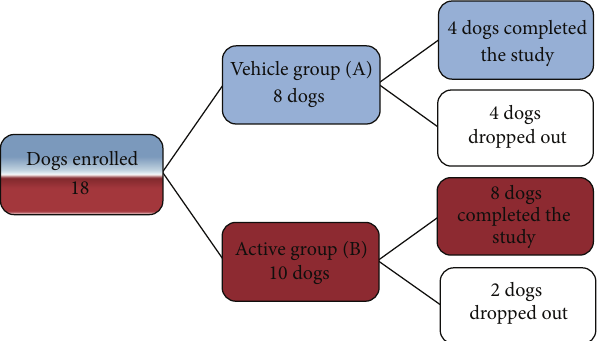
Figure 1: The flow chart shows the distribution of the dogs from the beginning to the end of the